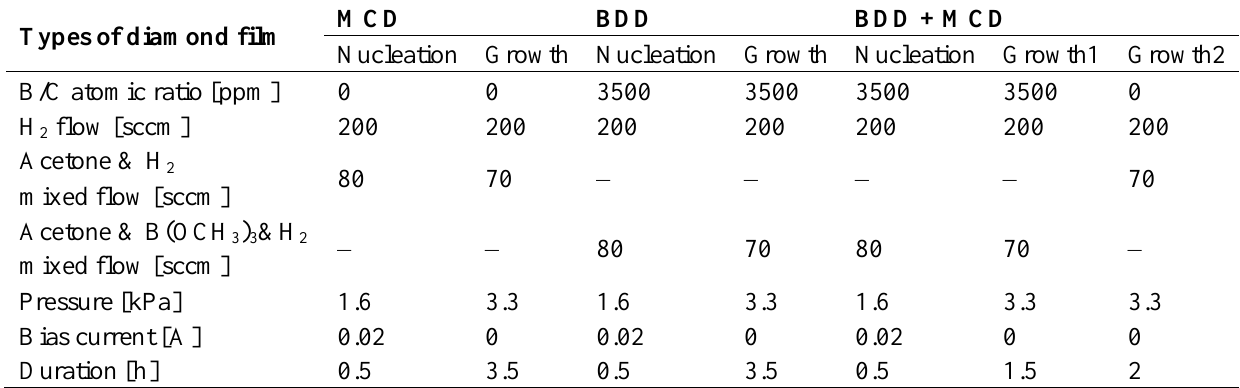
Table 1. Diamond film deposition